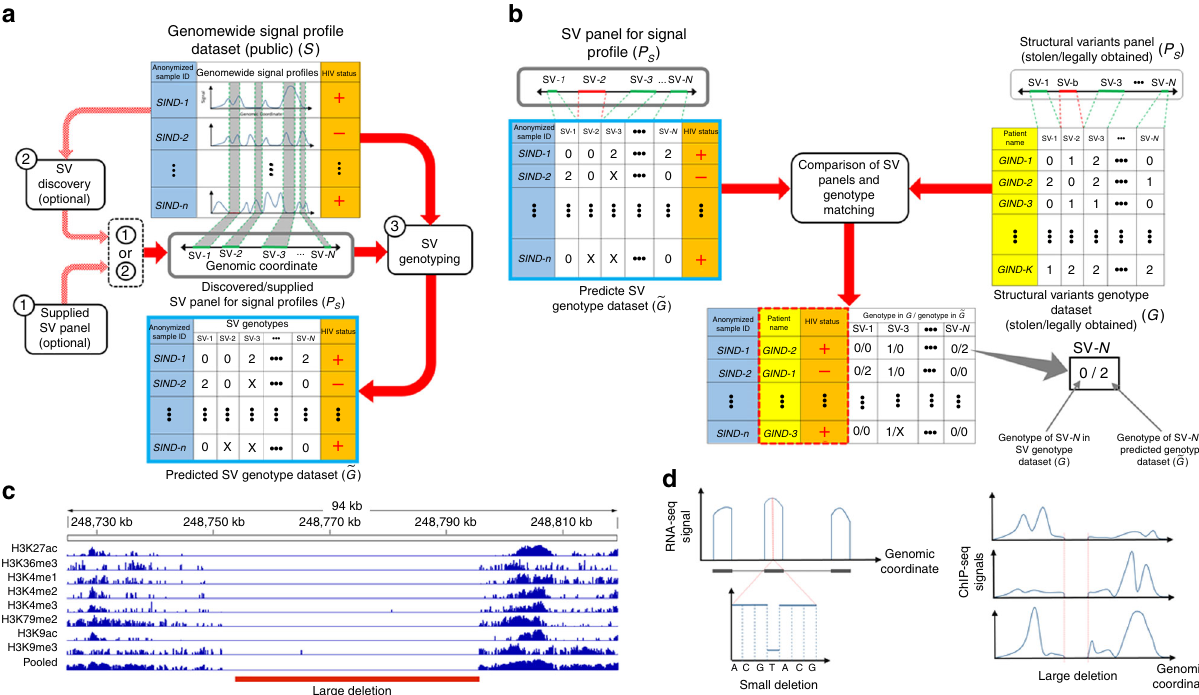
Fig. 1 Illustration of the attack scenario. a The adversary starts the attack with a signal pro fi le dataset ( S ). This dataset contains a genome-wide signal pro fi le and also sensitive information (e.g., HIV status) for each individual. The names are anonymized into IDs as shown in the blue shaded column. The adversary uses an SV panel ( P S ) in the attack. This panel can be obtained from outside (1) or the adversary can use the genome-wide signal pro fi les to discover the panel (2), as denoted by the shaded red arrows. The adversary then genotypes the SVs (3) in the panel and builds the dataset for genotyped SVs ð ~ G Þ . b The adversary acquires an SV panel ( P G ) and genotype dataset ( G ), which contains the genotypes of SVs in the panel for a large number of individuals. In order to link the genotyped SV dataset ð ~ G Þ to the SV genotype dataset, the adversary compares their SV panel ( P S ) to the SV panel ( P G ). For the matching SVs, the adversary compares the genotypes. The individuals in G who have good matches with respect to genotype distance are linked to signal pro fi le individuals, as indicated by the matching of colored columns. This linking reveals the HIV status of the individuals in the genotype dataset. c This example shows a large deletion in the NA12878 individual and how it affects signal pro fi les. A 70 kb long region is deleted in the NA12878 individual and the decrease in signal pro fi les show the loss of signal along the deletion. d This schematic shows large and small deletions and how they are manifested in signal pro fi les. The large deletions show a large decrease in the signal pro fi les, while the small deletions have much smaller